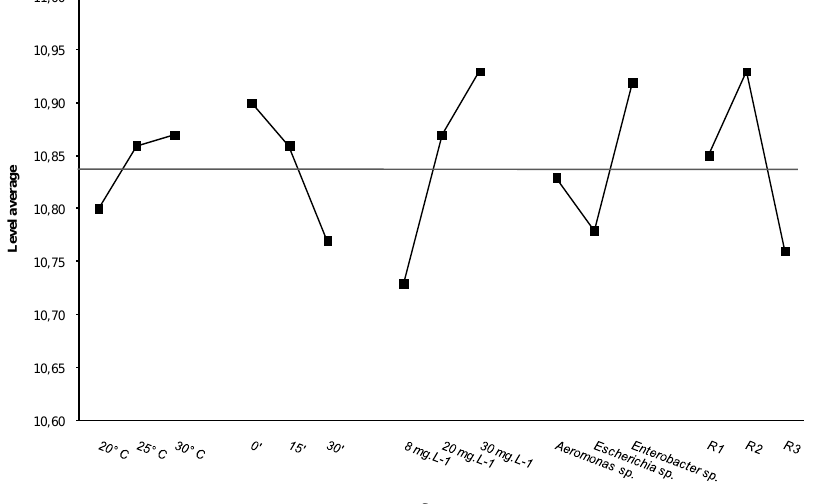
Figure 3. Values from the ANOVA test and the average midline of all